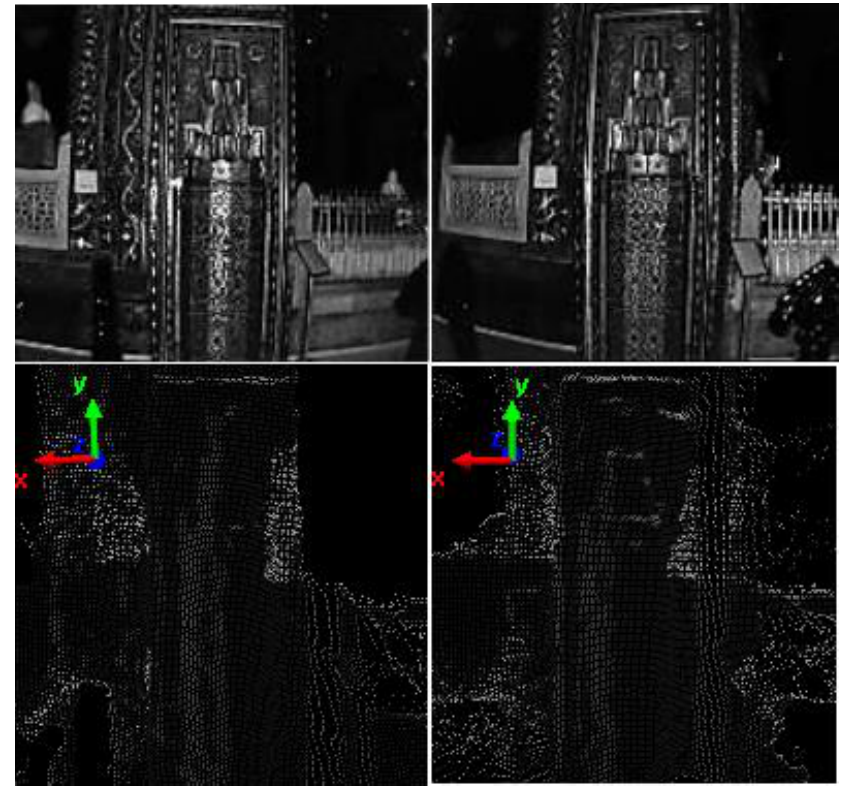
Figure 8. The Mihrab in Huzur-ı Pir section was measured with a SR4000 camera from two stations. Intensity images ( top ), and point clouds ( below